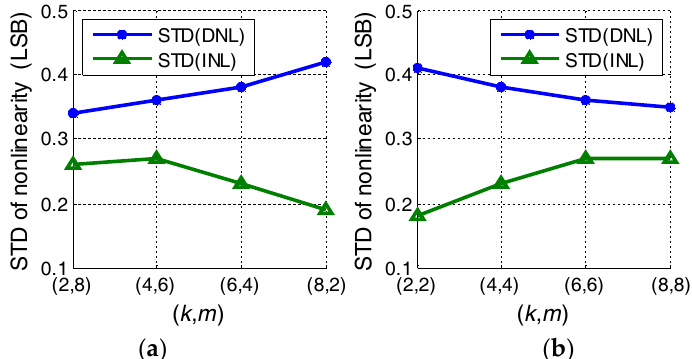
Figure 6. The predicted standard deviation (STD) of DNL and INL for different combinations of k and m for 100,000 Monte Carlo runs, using the matching resolution defined by Equations (19) and (20). ( a ) The ( k + m = 10) bit resolution of the R-I DAC. ( b ) k = m and K + M ranging from 4 to 16.